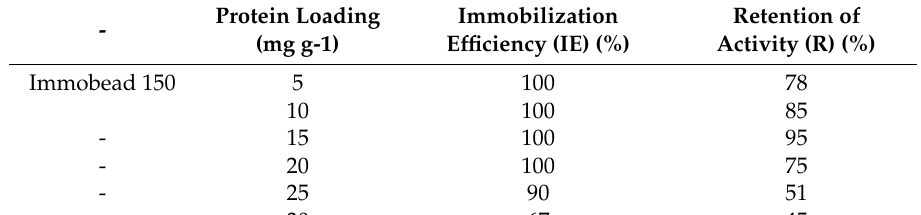
Figure 1. Synthesis of 2,5-dihydroxypyridine (2,5-DHP) by Immobead 150 (ImmHSPH ZZ ) at protein loading of ( ▲ ) 5, ( ◆ ) 10, ( ■ ) 15 and ( ▼ ) 20 mg g − 1 . The reactions were performed in 20 mM Tris-HCl buffer (pH 9.0) containing 0.75 mM HSP, 30 mg/mL ImmHSPH ZZ , 10 mM FAD and 0.5 mM NADH at 35 °C for 30 min.